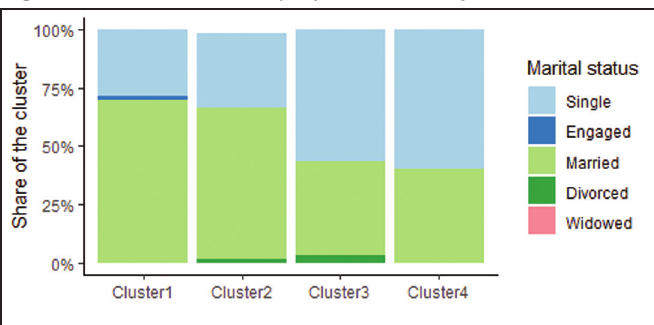
Share of unemployed women by marital